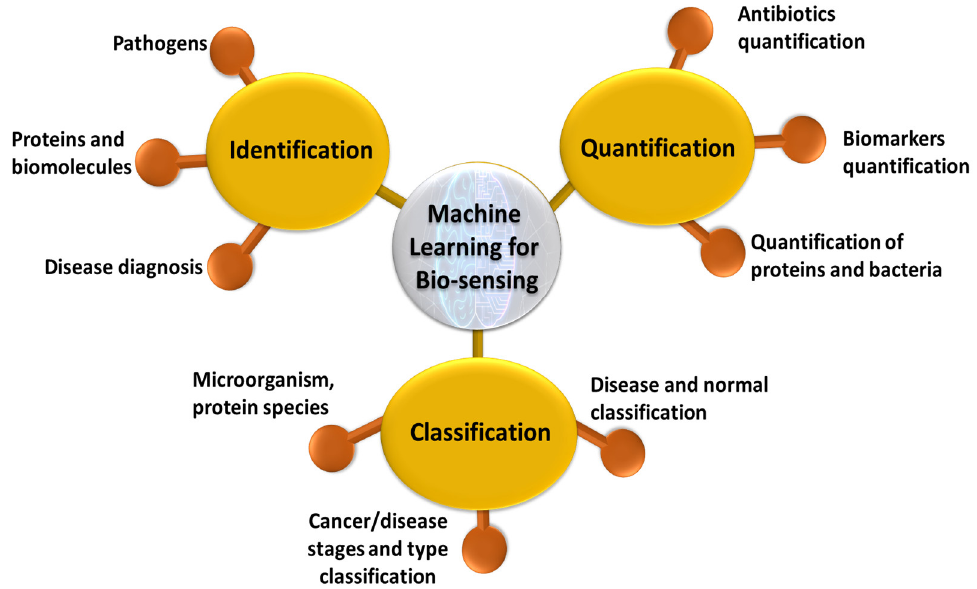
Figure 7. Schematic of applications of machine learning for biosensing using SERS based plasmonic sensors.